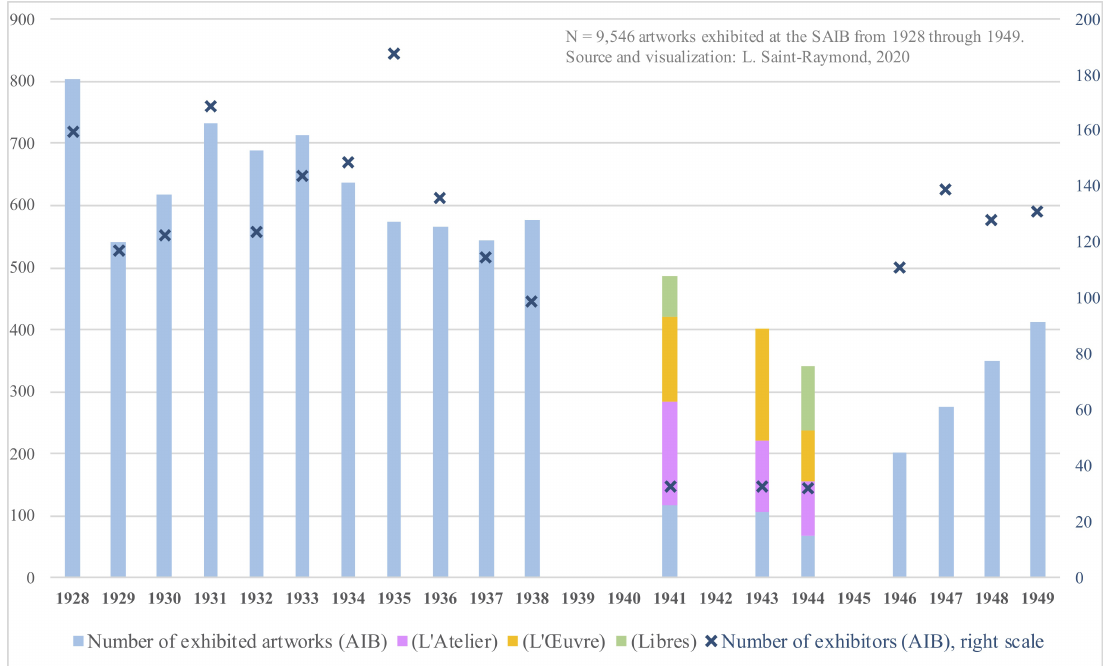
Figure 3. Number of exhibitors and exhibited artworks at the Salon des Artistes Indépendants bordelais,